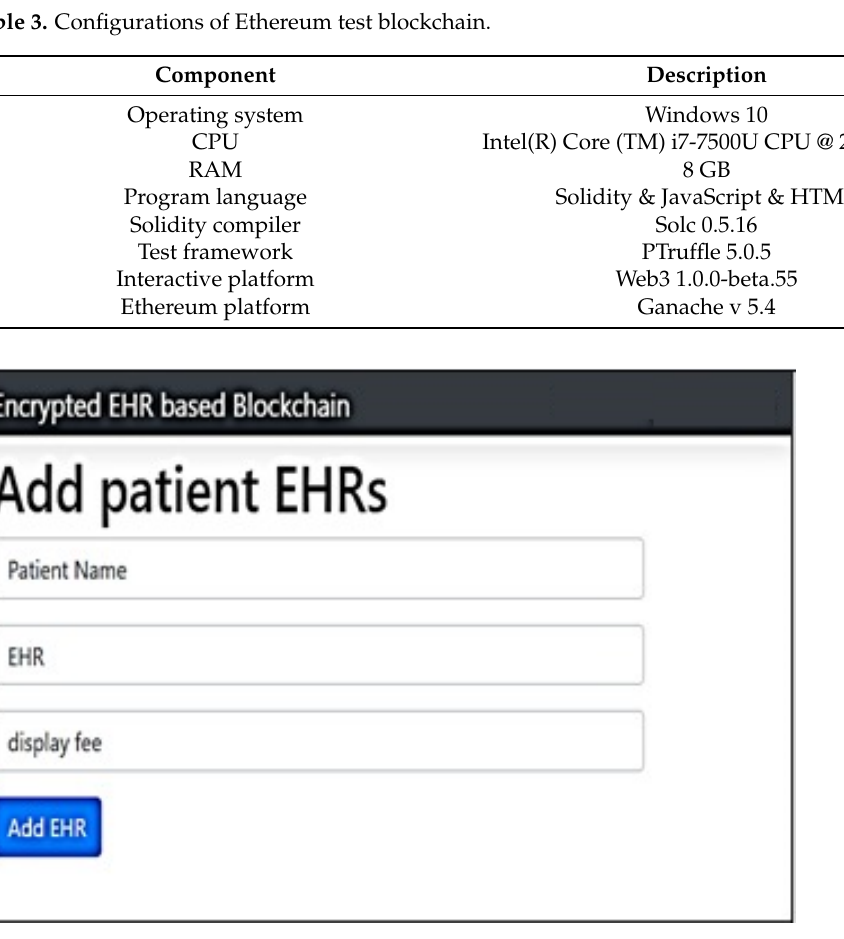
Figure 4. Front-end of our proposed